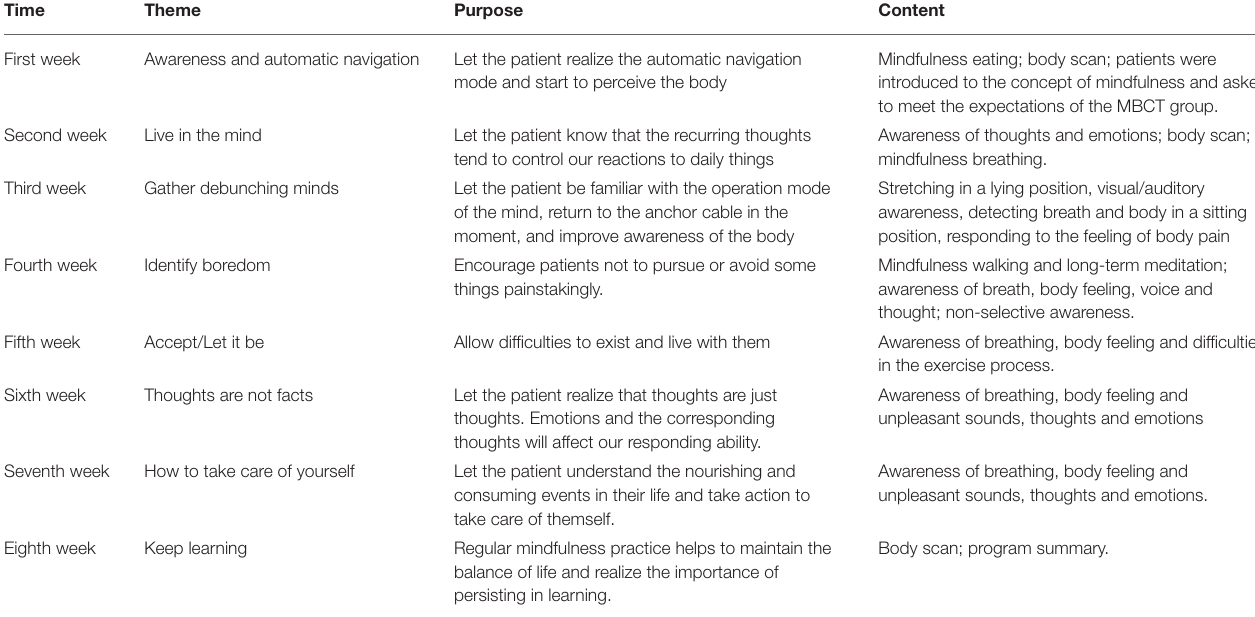
TABLE 2 | Arrangement of weekly intervention content.